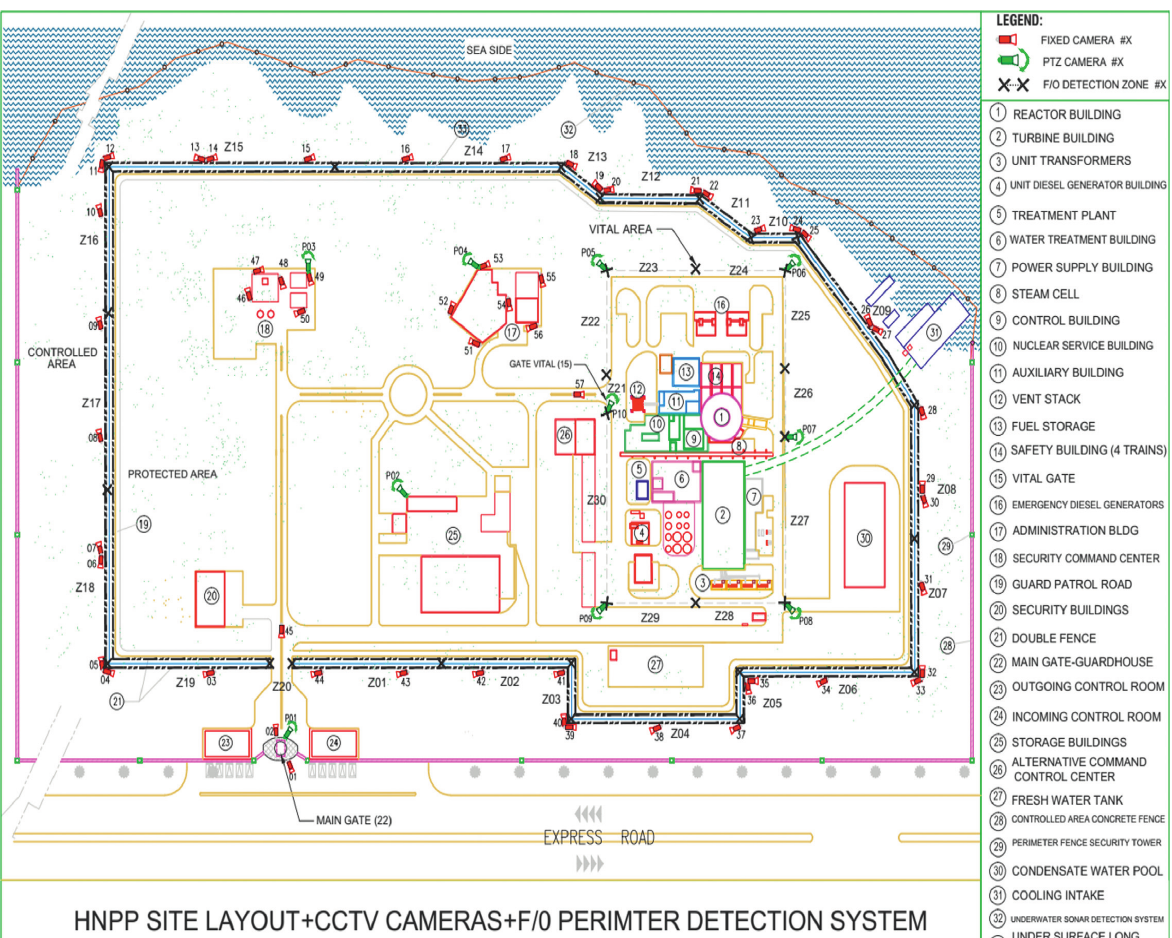
Figure 2: NPP site general location map with CCTV Cameras and F/O Perimeter Detection security